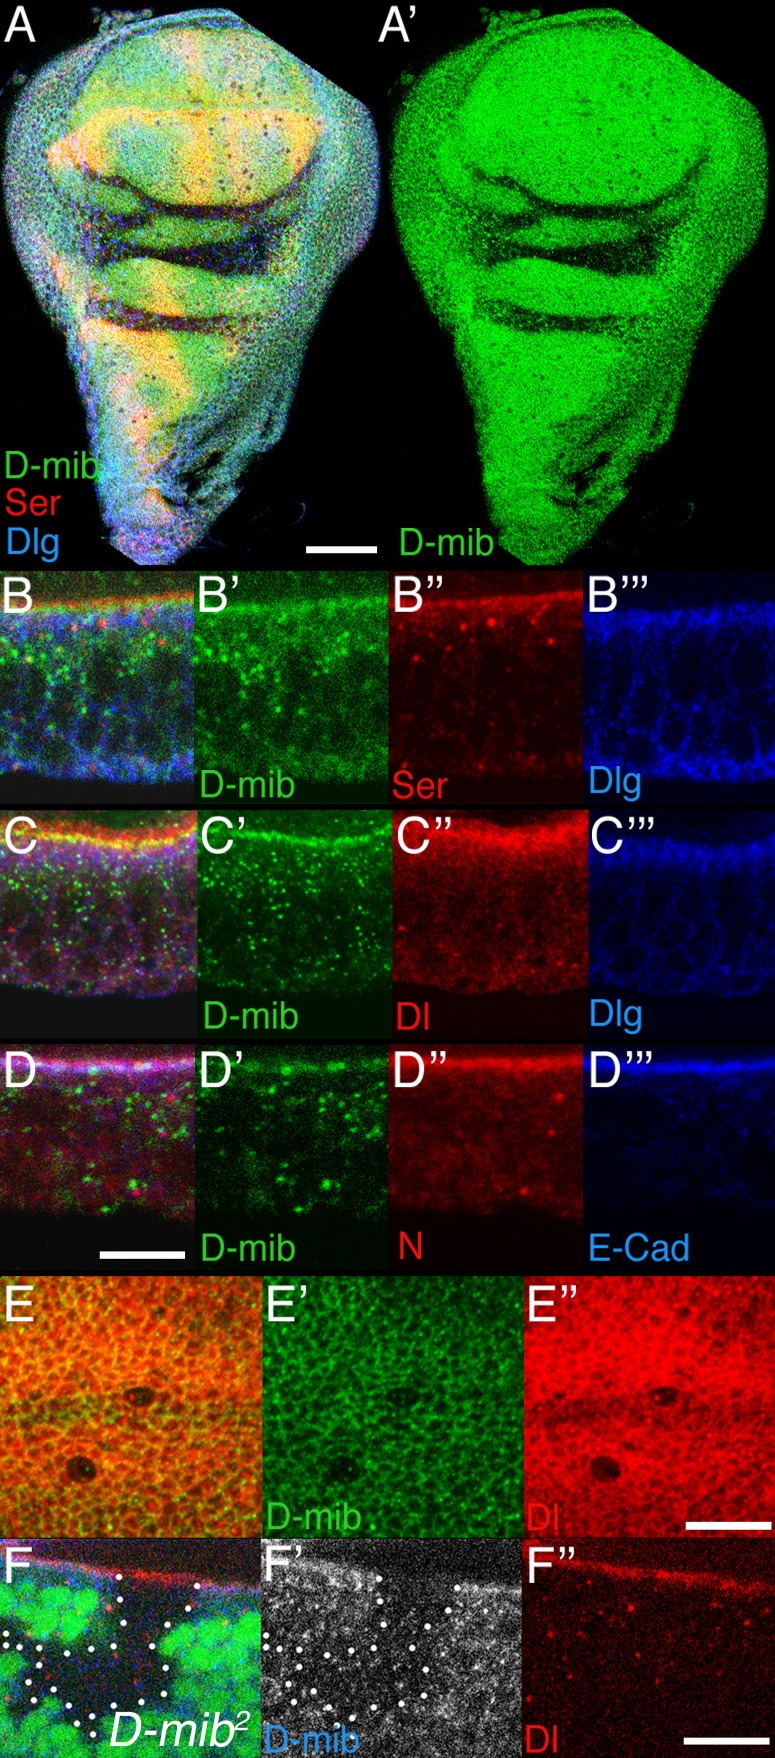
D-mib Co-Localizes with Dl and Ser at the Apical Cell Cortex(A and A′) D-mib (green) is detected in all cells of the wing imaginal disc. In (A), Ser is in red and Discs-large (Dlg) is in blue.(B–D′′′) D-mib (green in B, B′, C, C′, D, and D′) co-localized with Ser (red in [B and B′′]), Dl (red in [C and C′′]), N (red in [D and D′′]), and E-Cadherin (E-Cad; blue in [D and D′′′]) and was found apical to Discs-large (Dlg; blue in [B, B′′′, C, and C′′′]) in notum cells located at the edges of the wing discs.(E–E′′) D-mib (green in [E and E′]) co-localized with Dl (red in [E and E′′]) at the apical cortex of wing pouch cells.(F–F′′) D-mib staining at the apical cortex (blue in [F and F′]) was not detected in D-mib2 mutant clone (marked by loss of nuclear GFP staining; green in [F]). Loss of D-mib activity has no detectable effect on the apical accumulation of Dl (red in [F and F′′]).Bar is 50 μm for (A and A′) and 10 μm for (B–F′′).